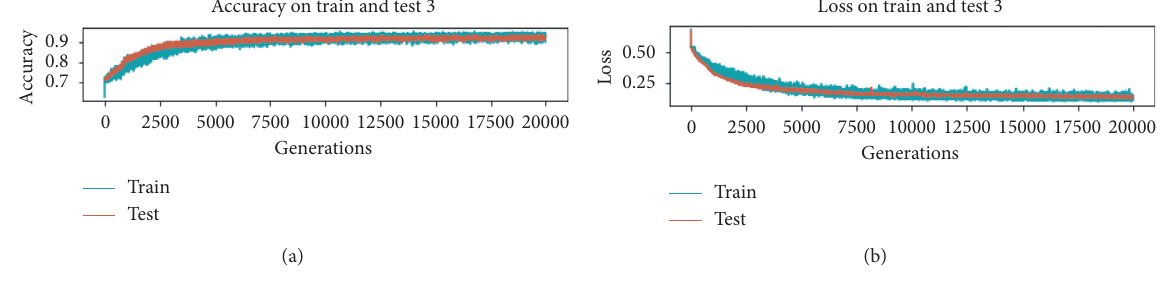
Figure 14: The accuracy (a) and the loss (b) for twice shrunk time window.